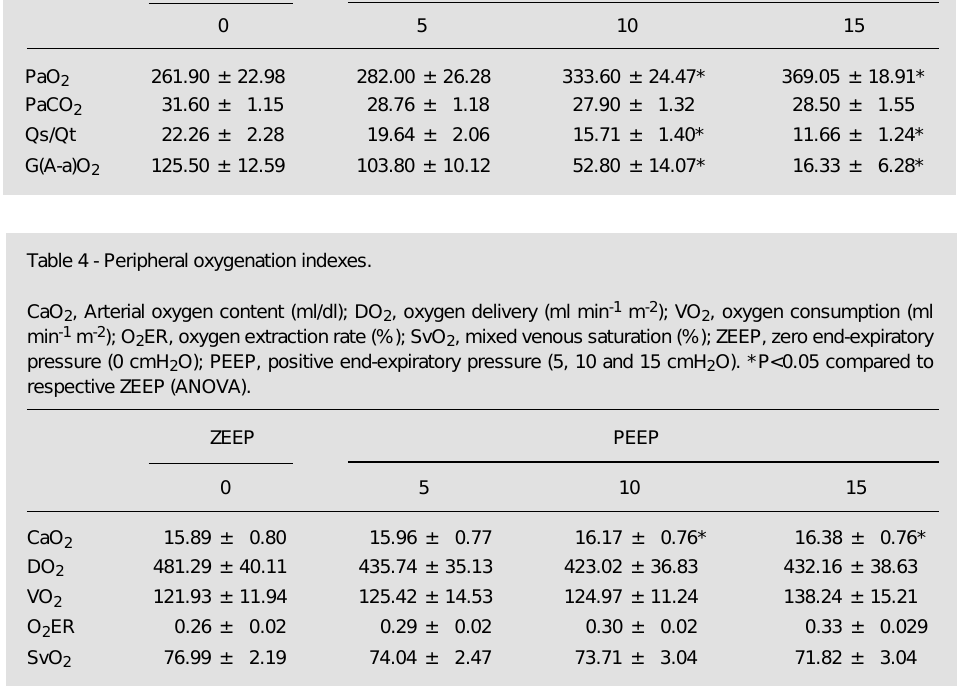
Table 3 - Respiratory data.